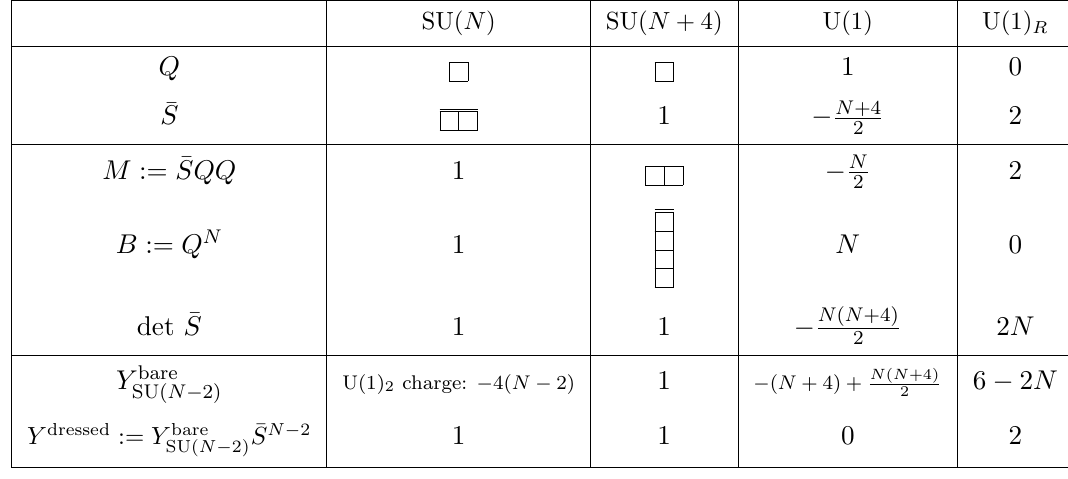
Table 4 . 3d N = 2 SU( N ) gauge theory with ( N + 4)